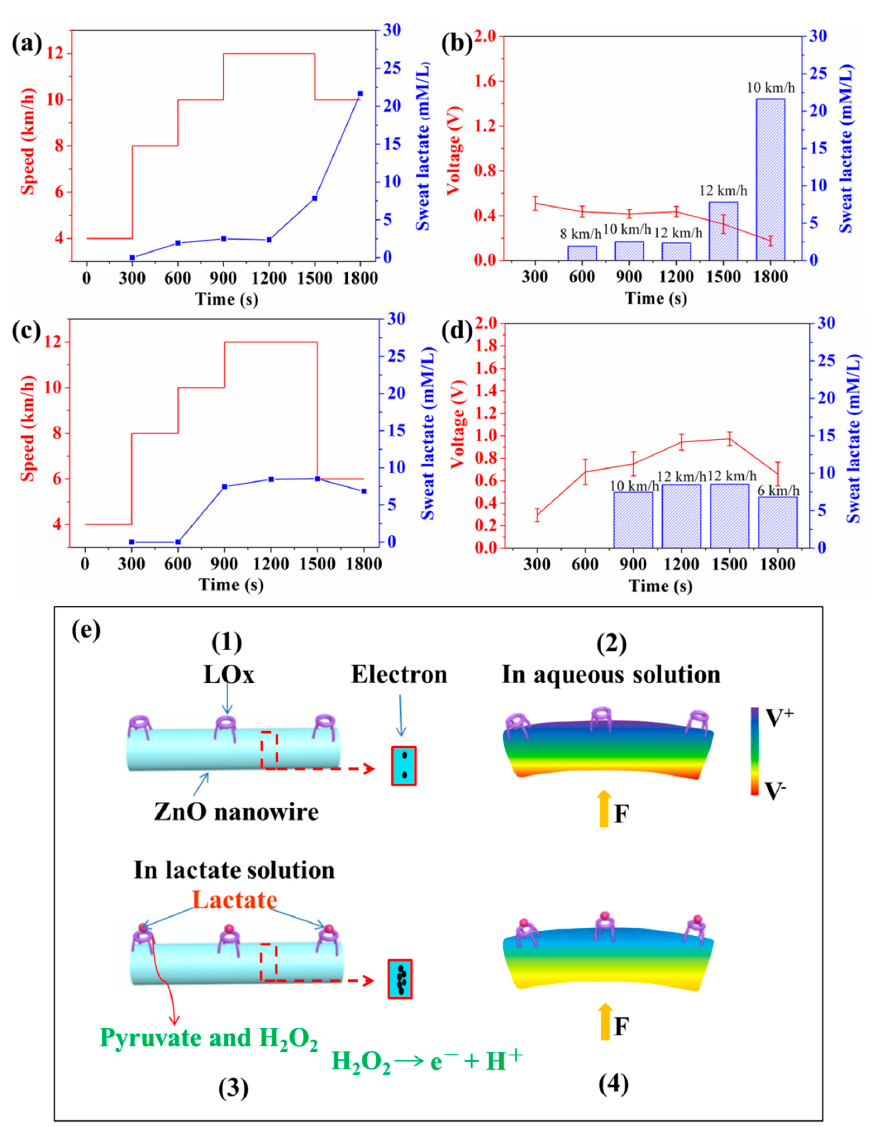
Figure 6. Self-powered piezoelectric-biosensing textiles for sweat-lactate analysis. ( a ) The relationship between the speed and sweat lactate concentration (measured by a commercial meter) for tester A. ( b ) The relationship between speed (lactate concentration) and output piezoelectric voltage of the device on tester A. ( c , d ) The experimental data for tester B. ( e ) Working mechanism diagram.